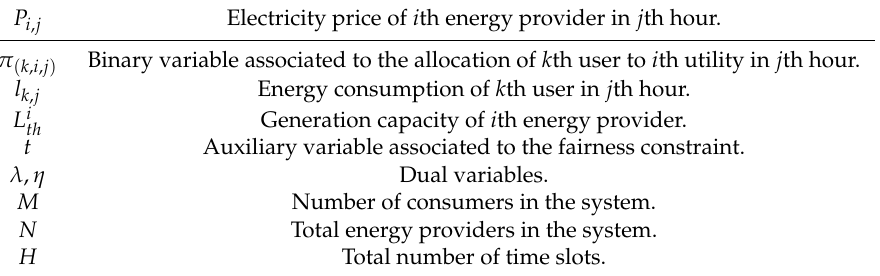
Table 1. variable